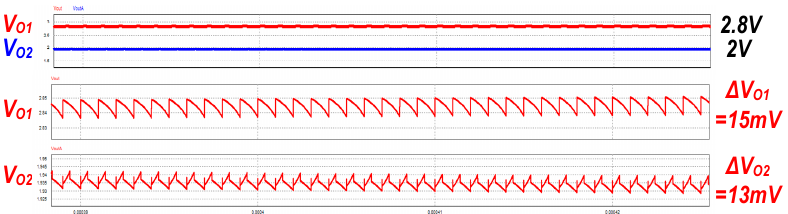
Figure 24. Simulated voltage waveforms of the proposed SIDOETM.